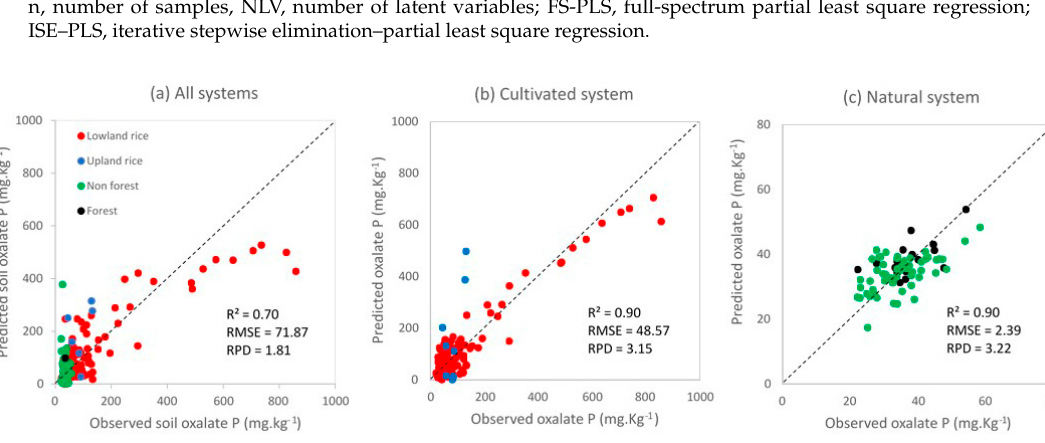
Figure 5. Relationships between observed and predicted values of soil oxalate-extractable P contents using ISE–PLS (iterative stepwise elimination–partial least square) regression with first derivative reflectance data for ( a ) natural systems ( n = 74), ( b ) cultivated systems ( n = 142), and ( c ) all systems combined ( n = 216). RMSE, root mean square error; RPD, residual predictive deviation.